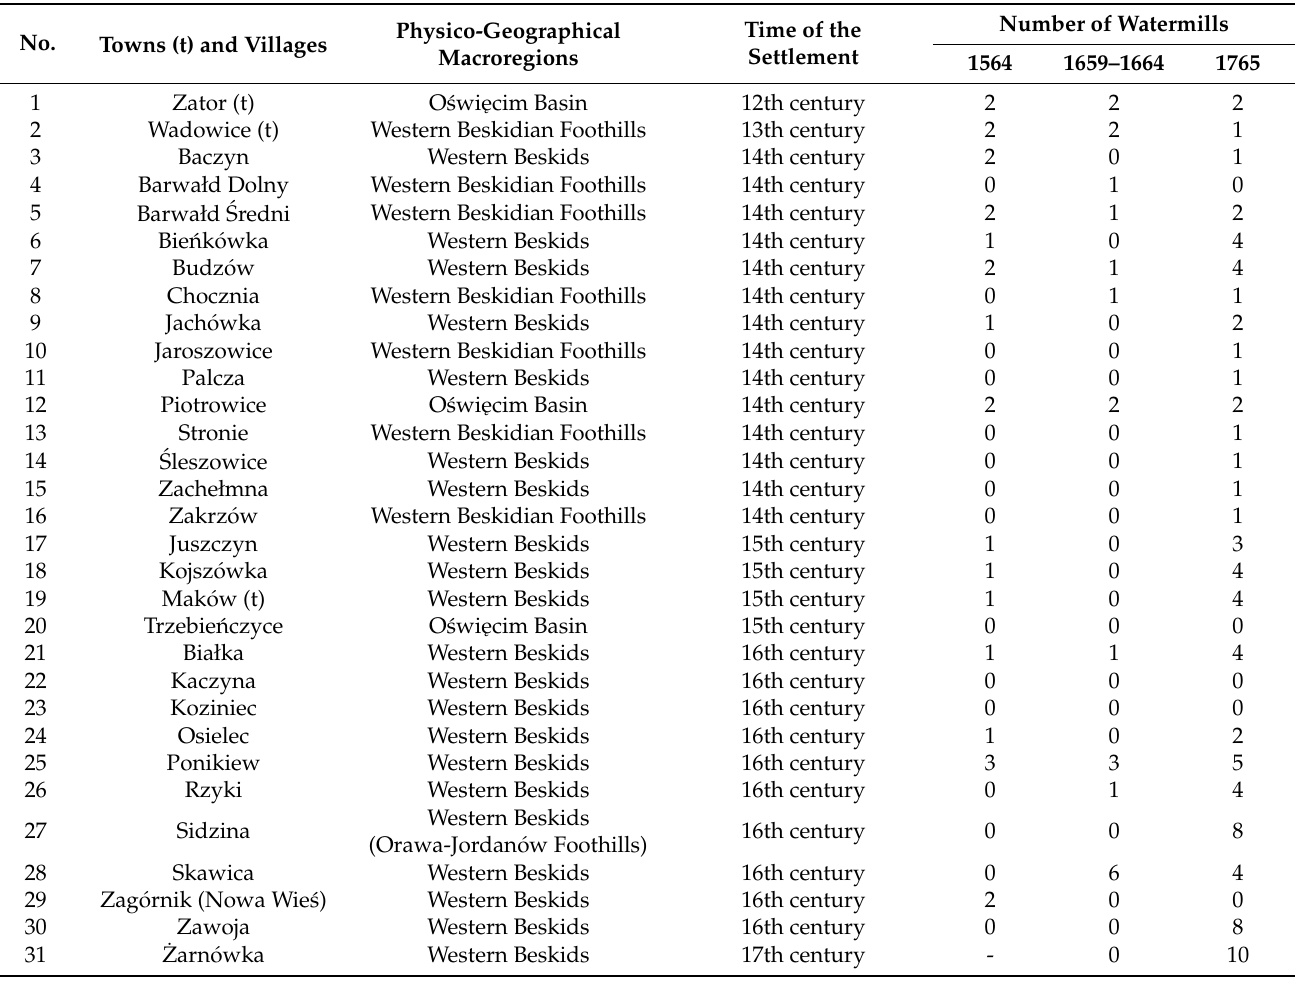
Table A1. Number of watermills in towns and villages belonging to royal estates according to the inspection from 1564 [19], 1659–1664 [20] and 1765